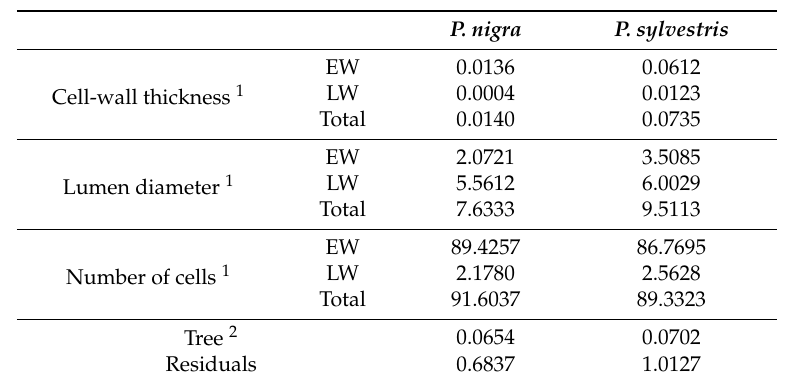
Table 2. Variance in tree-ring width explained (in %) by different anatomical features in its two components (EW, earlywood; LW, latewood) in the mixed effects model TRW = a i · CWT ew + b i · CWT lw